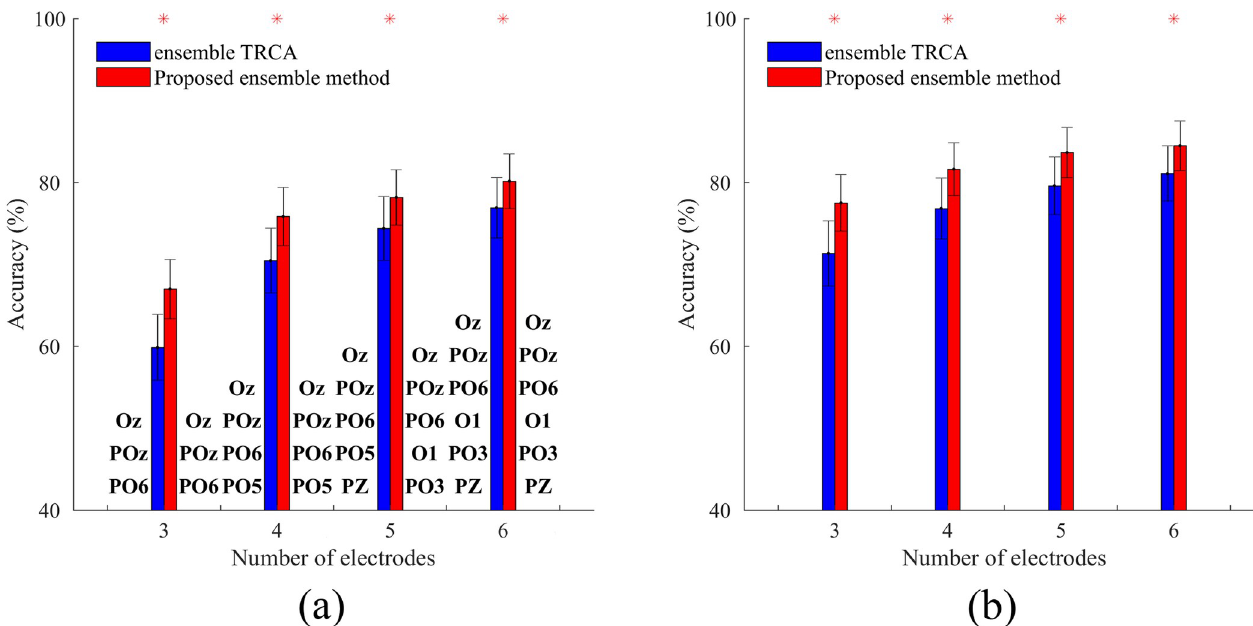
Fig 8. Relation between the maximum achievable accuracy and the layout of the electrodes. (a) the best layout of the electrodes per method, derived from a grid search for all subjects and the corresponding average accuracies; and (b) the potential average accuracies across the subjects after selecting the best layout of the electrodes per subject. In both figures, the data length is 0.5 s. Asterisks represent a significant difference between the two methods by paired t-tests ( � p < 0.001). Error bars show standard errors.